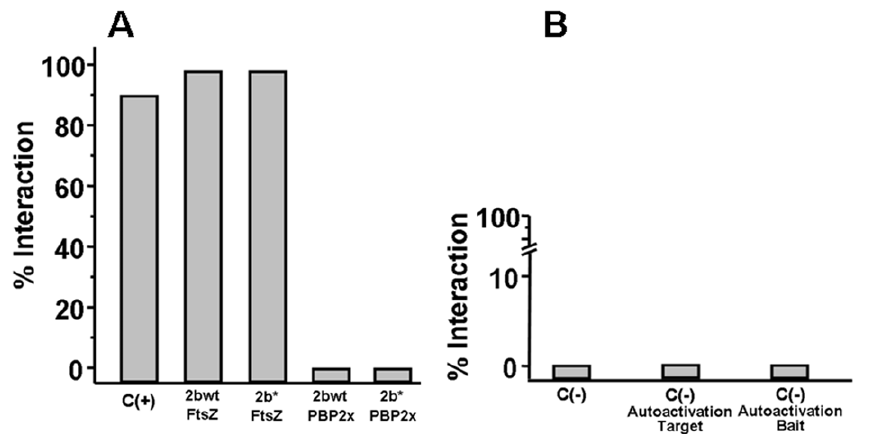
Figure 7. Bacterial two hybrid assay. The percentage of interaction is defined as the ratio between the number of cells co-transformed able to grow in 3-AT selective medium and the total number of cells obtained in medium without 3-AT. The plasmid pair pBT-LGF2/pTRG-Gal11 (BacterioMatch II, Stratagene) was used as a positive control. A) Interaction of PBP2b wt -FtsZ and PBP2b 28 -FtsZ B) As negative controls, the following plasmid pairs were used: pBT/pTRG carrying codifying sequences of non-interacting proteins, C (-); pBT-empty/pTRG-recombinant, to evaluate the two-hybrid system auto-activation for the target proteins (-)/Autoactivation Target; pBT-PBP2b/pTRG-empty, as non-specific transcription activation control mediated by PBP2b wt or PBP2b 28 , C (-)/Autoactivation